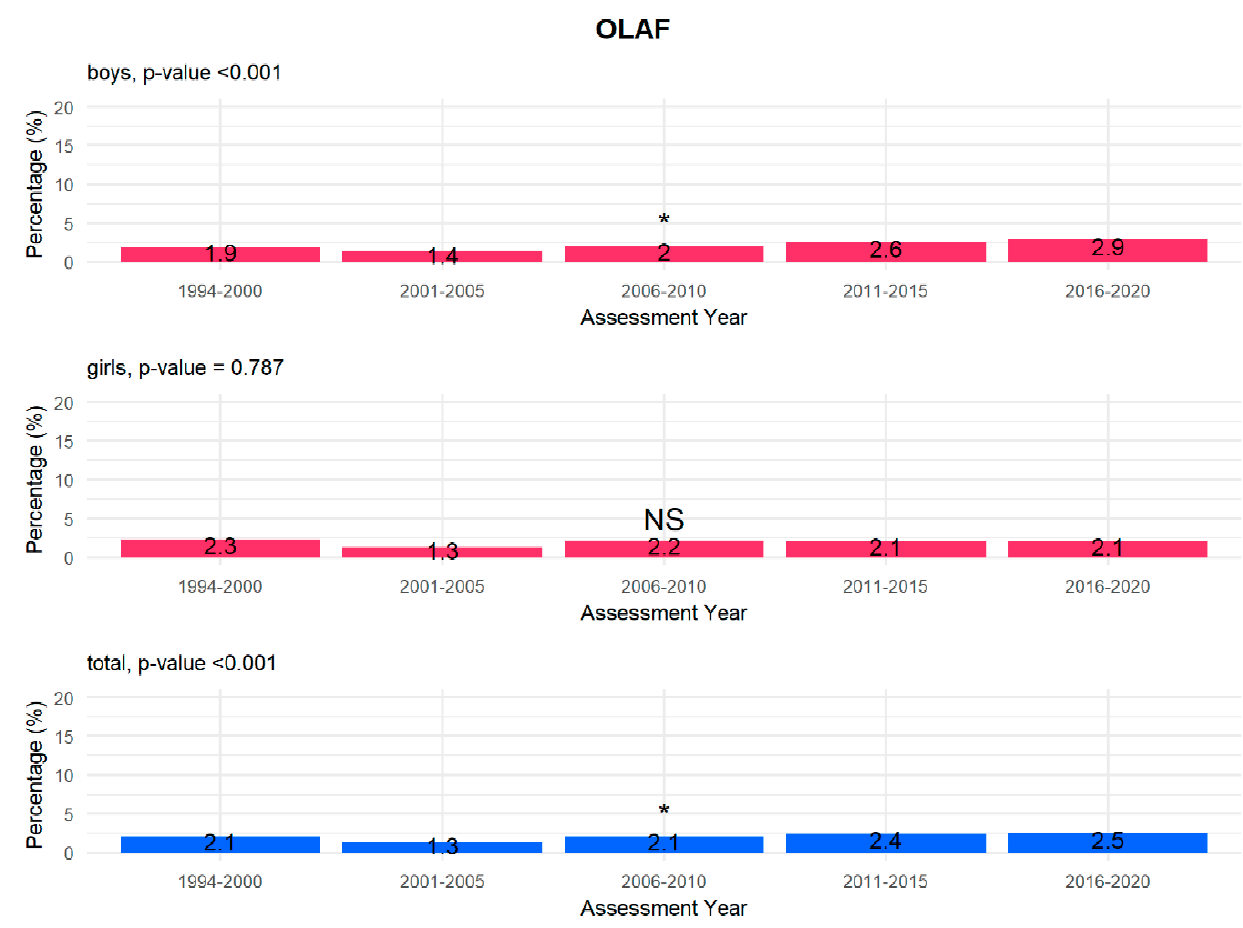
Figure 2. Prevalence of underweight children according to the WHO criteria by gender and year (total p value < 0.001, boys p value < 0.001, girls p value 0.603). *—significant linear trend, NS—not significant.